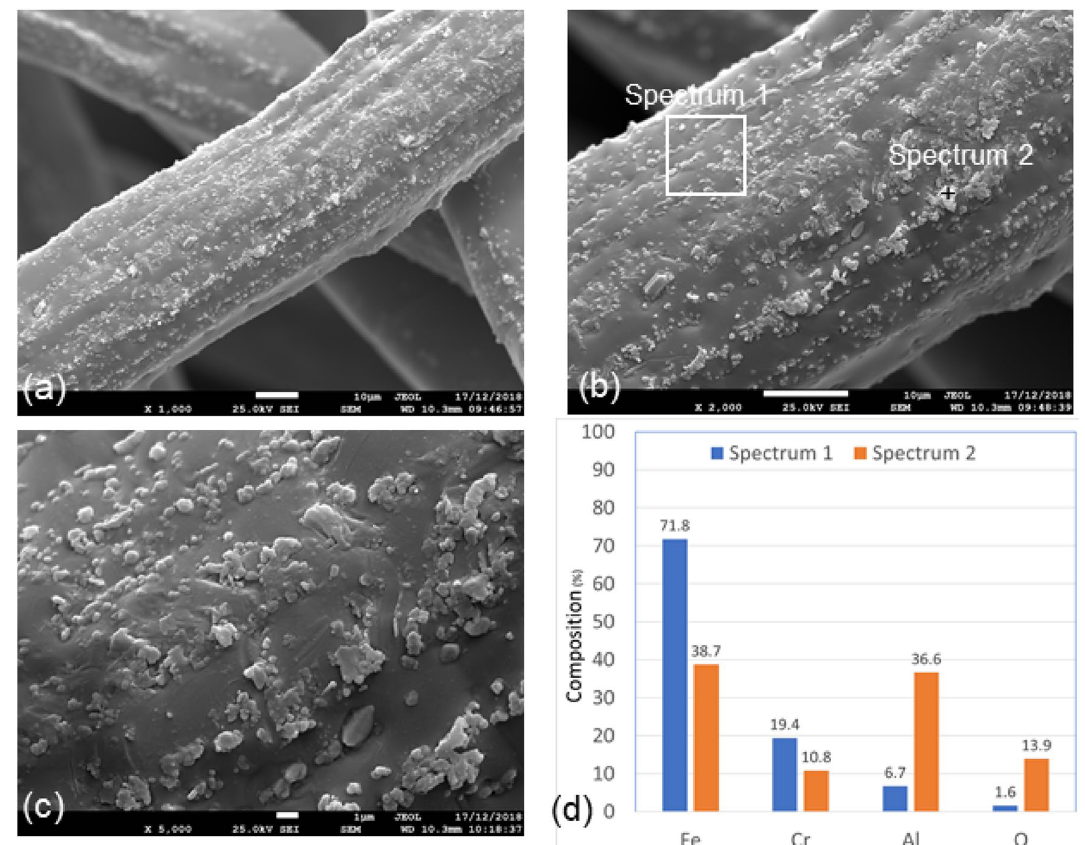
Figure 6. SEM micrograph images and EDS analysis of Sample 1, without heat treatment–as received, FeCrAl fibers at different magnifications, ( a ) × 1000; ( b ) × 2000; ( c ) × 5000; ( d ) EDS scans of Spectrum 1 and Spectrum trum 1 and Spectrum 2. Spectrum 1 represents scan of a selected area, including some nodules, while Spectrum 2 represents a spot scan of a nodule on the surface of the metal fiber. The results of the EDS analyses, presented in Fig. 6d, show that Spectrum 1 has an elemental composition of 71.8% iron, 19.4% chromium, and 6.7% aluminum, which are approximately similar to the base metal alloy shown in Table 3. The results of Spectrum 2, however, show that the nodule has an aluminum content of 36.6% and oxygen contents of 13.9%, which are much higher than the average aluminum and oxygen contents on the surface of the fiber. Sample 2: after one MSHT cycle. Figures 7(a-c) show three SEM micrograph images of different magnifications of Sample 2 with nonuniform morphology of the oxide-scale layer. The micrograph images show a forest with platelet-like morphology. They also show nonuniform surface morphology, with gabs displaying relatively a smooth oxide-scale layer with no distinct features on the surface. Elemental compositions of Spectrum 3, for an area with a smooth oxide-scale layer, and Spectrum 4, for a forest with platelet-like morphology are displayed in Fig. 7d. Compared to Spectrum 3, Spectrum 4 shows more aluminum and oxygen and less iron and chromium. The results indicate there is nonuniform aluminum diffusion on the surface of the fibers. Furthermore, the elemental compositions of Spectrums 3 and 4 show aluminum contents of 29.7% and 40.5% and oxygen contents of 11.8% and 28.2%, which are higher compared to the elemental chemical composition of the base metal shown in Table 3. The results confirm the formation of the Al 2 O 3 -base protective layer on the fibers by the multistage thermal oxidation. A cross-section polisher (JEOL-SM-09010) was used to prepare cross-sections of Sample 2 fibers for SEM and EDS analyses. The sample was placed in the holder, and an optical microscope was used to select the spot to be irradiated by the argon-ion beam. A high-quality cross-section of the 40 μm fiber, shown in Fig. 8a, was then chosen for further analysis. EDS scans were performed on a circular area approximately on the center of the fiber and along a line starting from the outer edge of the oxide-scale layer into few microns of the base-metal. The results of the EDS scan of the circular area, Spectrum 5, are shown in Fig. 8b. After one MSHT cycle, the aluminum composition in the center of the fiber is slightly less than that of the FeCrAl elemental composition shown in Table 3, indicating limited diffusion of aluminum from the base metal to the surface of the fiber. The x-ray EDS line scan count data in Fig. 8c show high concentrations of aluminum and oxygen and low levels of iron and chromium on the oxide-scale layer compare to the base-metal. After one MSHT cycle, the thickness of the oxide-scale layer varies from 0.4 μm to 0.6 μm. Figure 9 shows x-ray maps for iron, chromium, aluminum, and oxygen. The results of the aluminum and oxygen x-ray maps confirm the formation of a thin